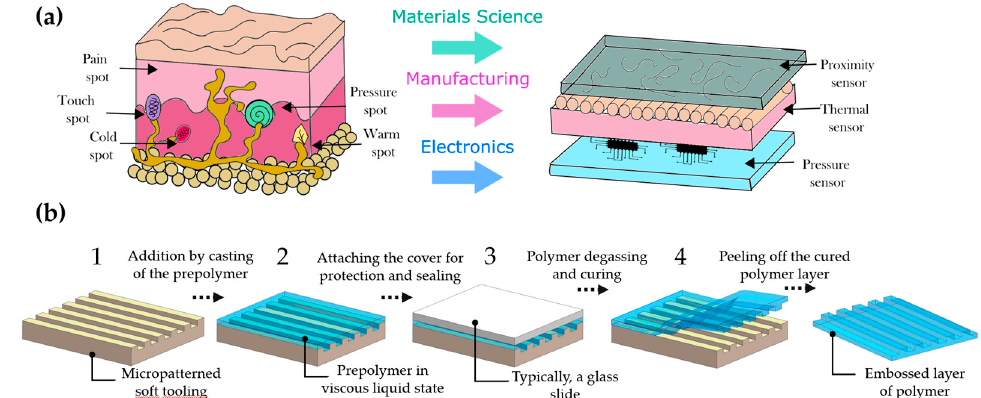
Figure 1. ( a ) Structure and sensing mechanisms of artificial electronic skin ( right ) and biological skin ( left ); ( b ) schematic illustration of the fabrication process of casting layers using soft tooling; ( 1 ) the first step is to clean the mold, ( 2 ) next, in the second step, the material is cast into the mold; ( 3 ) after coating and sealing via a protective substrate, the third step consists of degassing using some vacuum chambers and some negative pressure sources; finally, ( 4 ) curing is performed in a convection oven or other heat source prior removal.